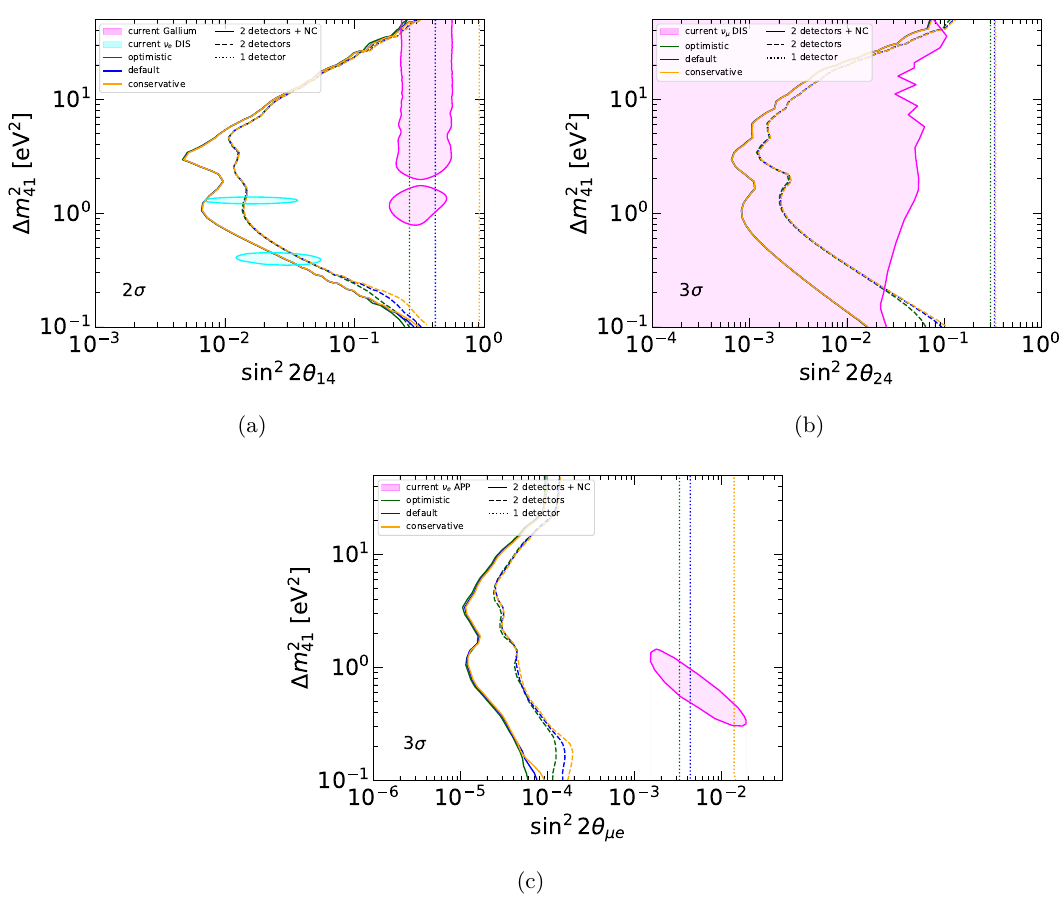
Figure 8 . Sensitivity reach of ESS ν SB in the (a) sin 2 2 ϑ 14 - ∆ m 2 (at 2 σ ), (b) sin 2 2 ϑ 24 - ∆ m 2 41 41 (at 3 σ ), and (c) sin 2 2 ϑ µe - ∆ m 2 (at 3 σ ) planes. For comparison, in (a) we show also the regions 41 preferred by the Gallium data and the regions preferred by the global ν e disappearance analysis without Gallium data [64], in (b) we show the bound obtained from a global ν µ disappearance analysis (the bound in ref. [51] updated with the latest IceCube data [83]), and in (c) we show the preferred region obtained from a global ν e appearance analysis